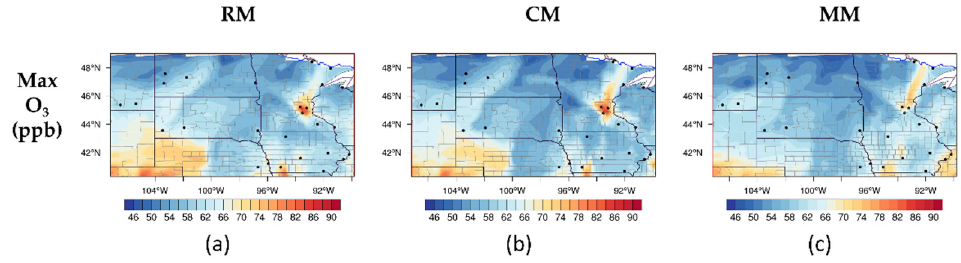
Figure 3. Predicted maximum hourly O 3 concentration (ppb) during July 2010. Model predictions for ( a ) RACM-MADE/SORGAM (RM), ( b ) CBMZ-MOSAIC (CM), and ( c ) MOZART-MOSAIC